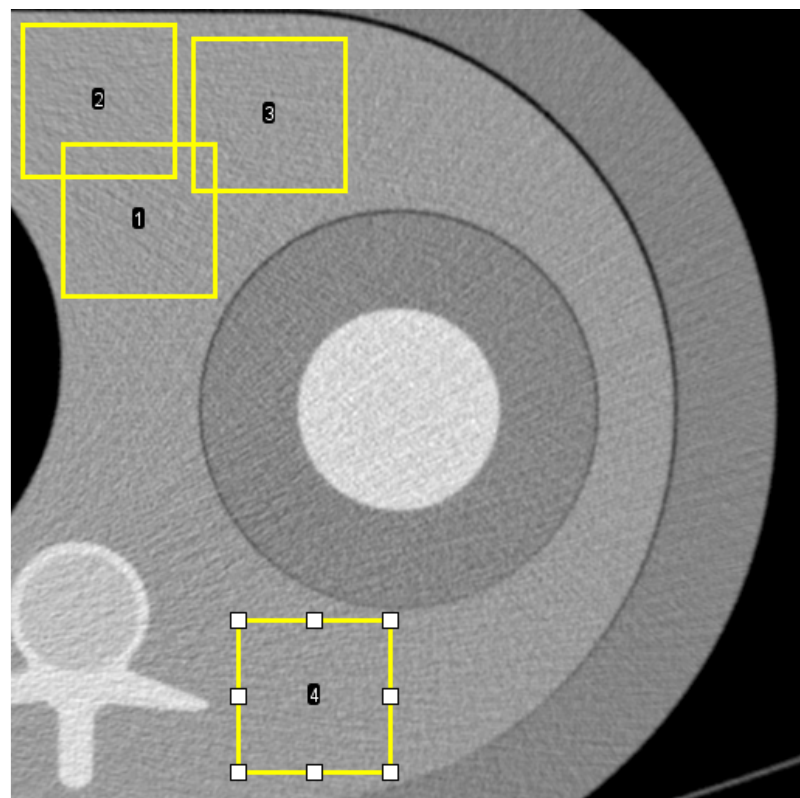
Figure 2. Axial CT image shows four examples (1, 2, 3, and 4) of region ‐ of ‐ interest (ROI) placement in the medium phantom for calculation of noise power spectrum (NPS). The position is similar in small and large phantoms.